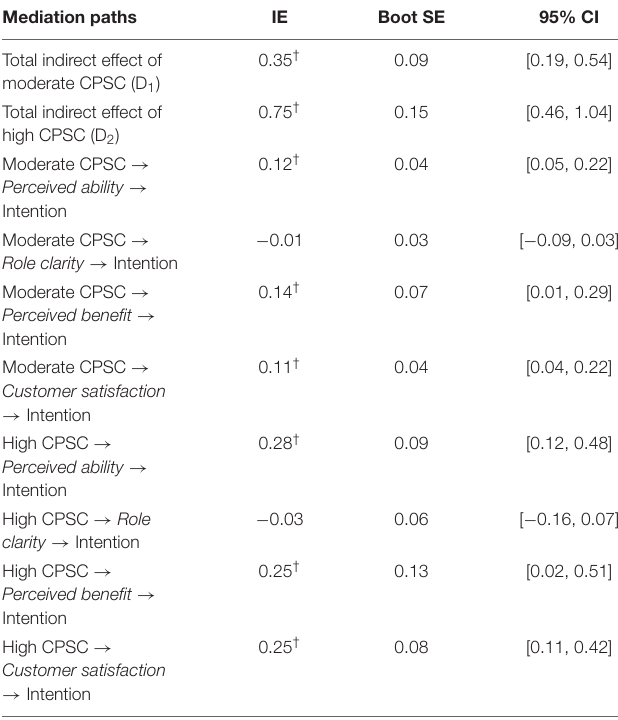
TABLE 5 | Indirect effects of CPSC on customer continuance